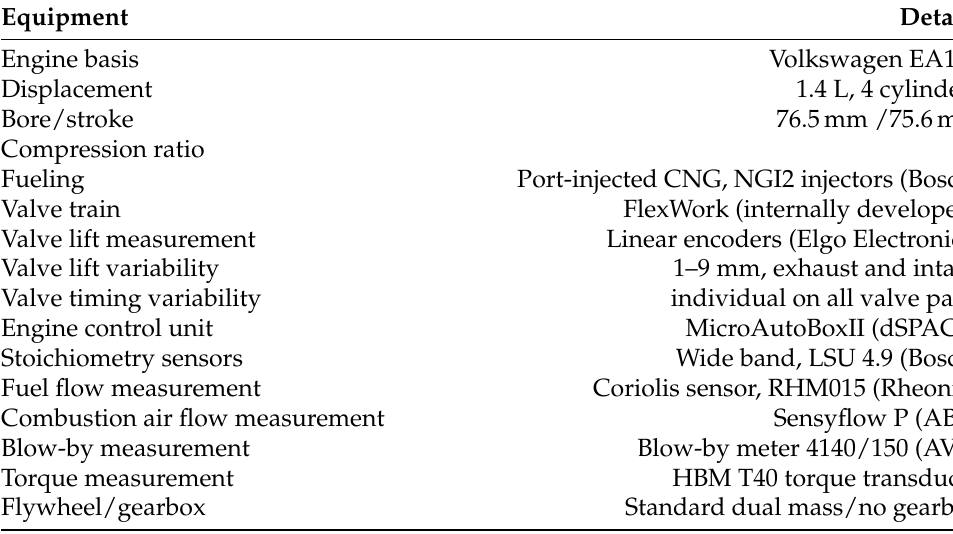
Table 1. Details of the equipment used on the engine test